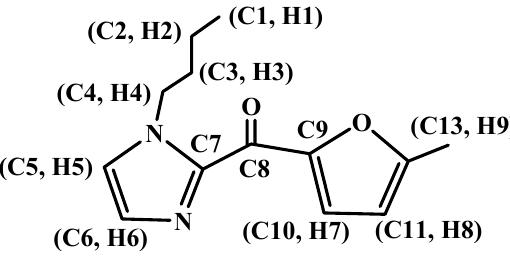
Figure 5. H-H COSY spectrum of the compound BMI in DMSO-d